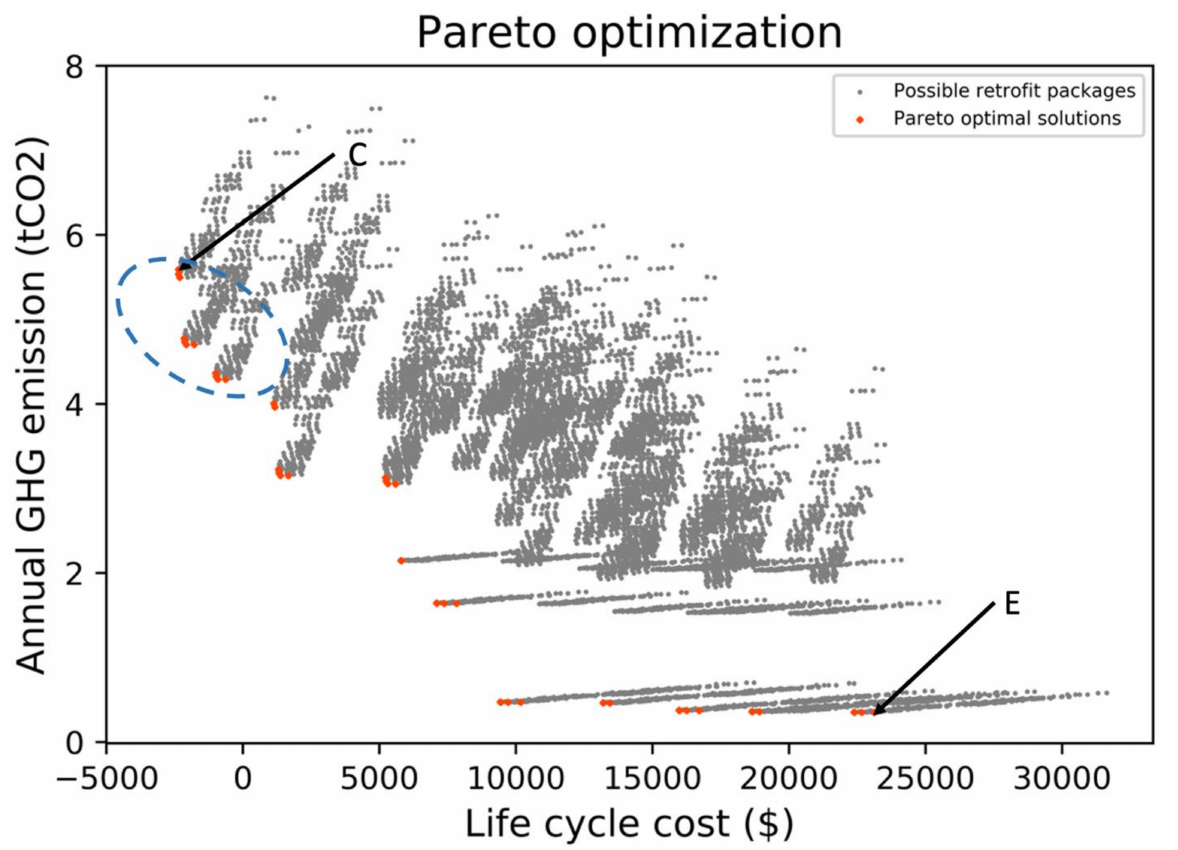
Figure 7. Pareto optimal retrofit